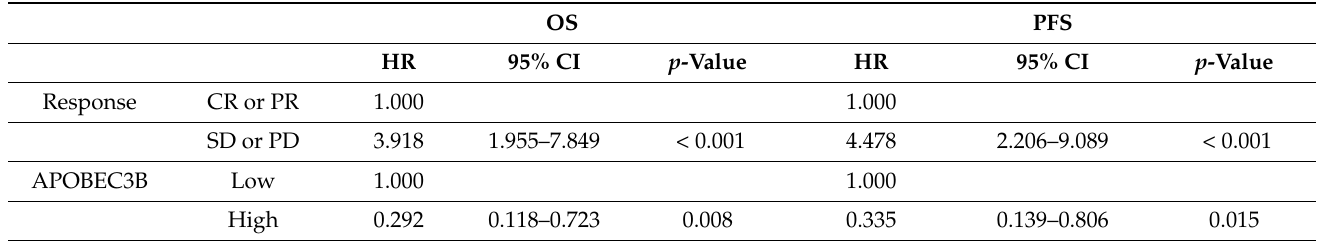
Figure 1. Survival curves according to APOBEC3B expression. ( a ) Overall survival, ( b ) Progression free survival. Table 2. Hazard ratio by Cox regression